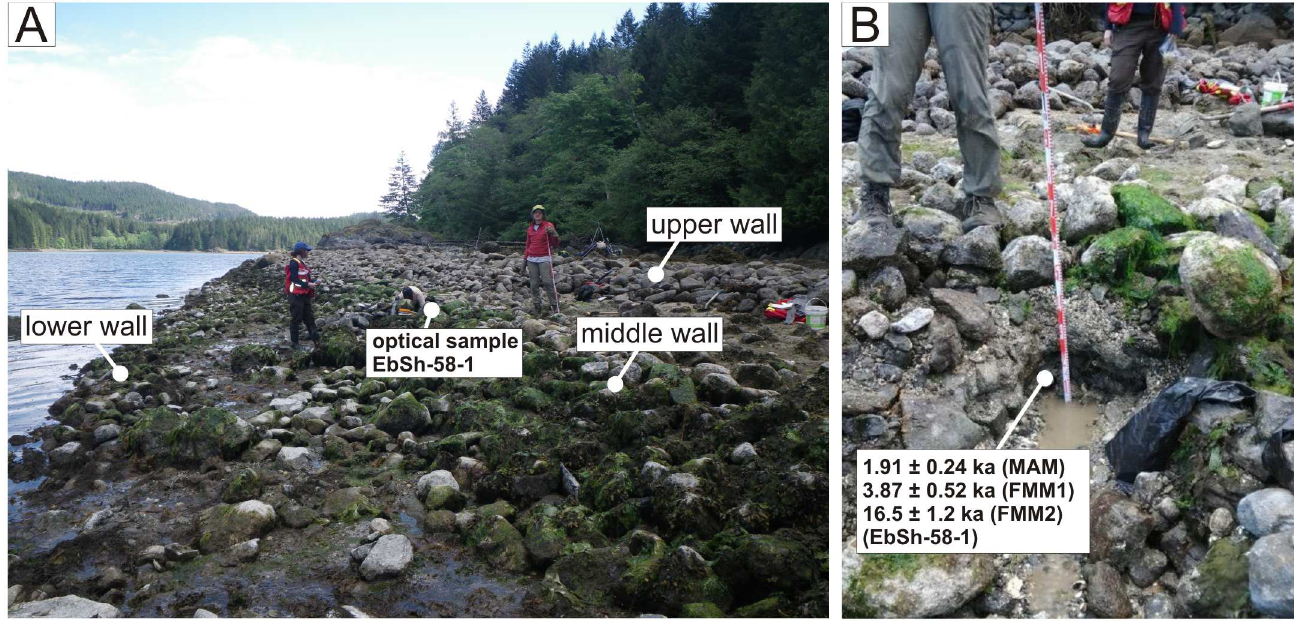
from a Nucellasp . shell collectedfrom the surface of the pre-garden beachunderlyingthe highestterrace, suggestingthat the pre-gardenbeachsurface underlyingboth the middleand upper walls is ~1200–2400 years old. These ages provide the best maximum age estimates of wall constructionon the middle and highestterraces. The youngestFinite Mixture Model (FMM) component(2.83–4.91ka) is consistent with a pre-wallconstructionradiocarbon age of 3336–3799cal years BP from a S . gigantea shell in growth position found trapped below the middlewall. The older FMM component(16.5 ± 1.2 ka) dates back to early postglacial time, and likely records the deposition of outwash sand by glaciersproximal to site